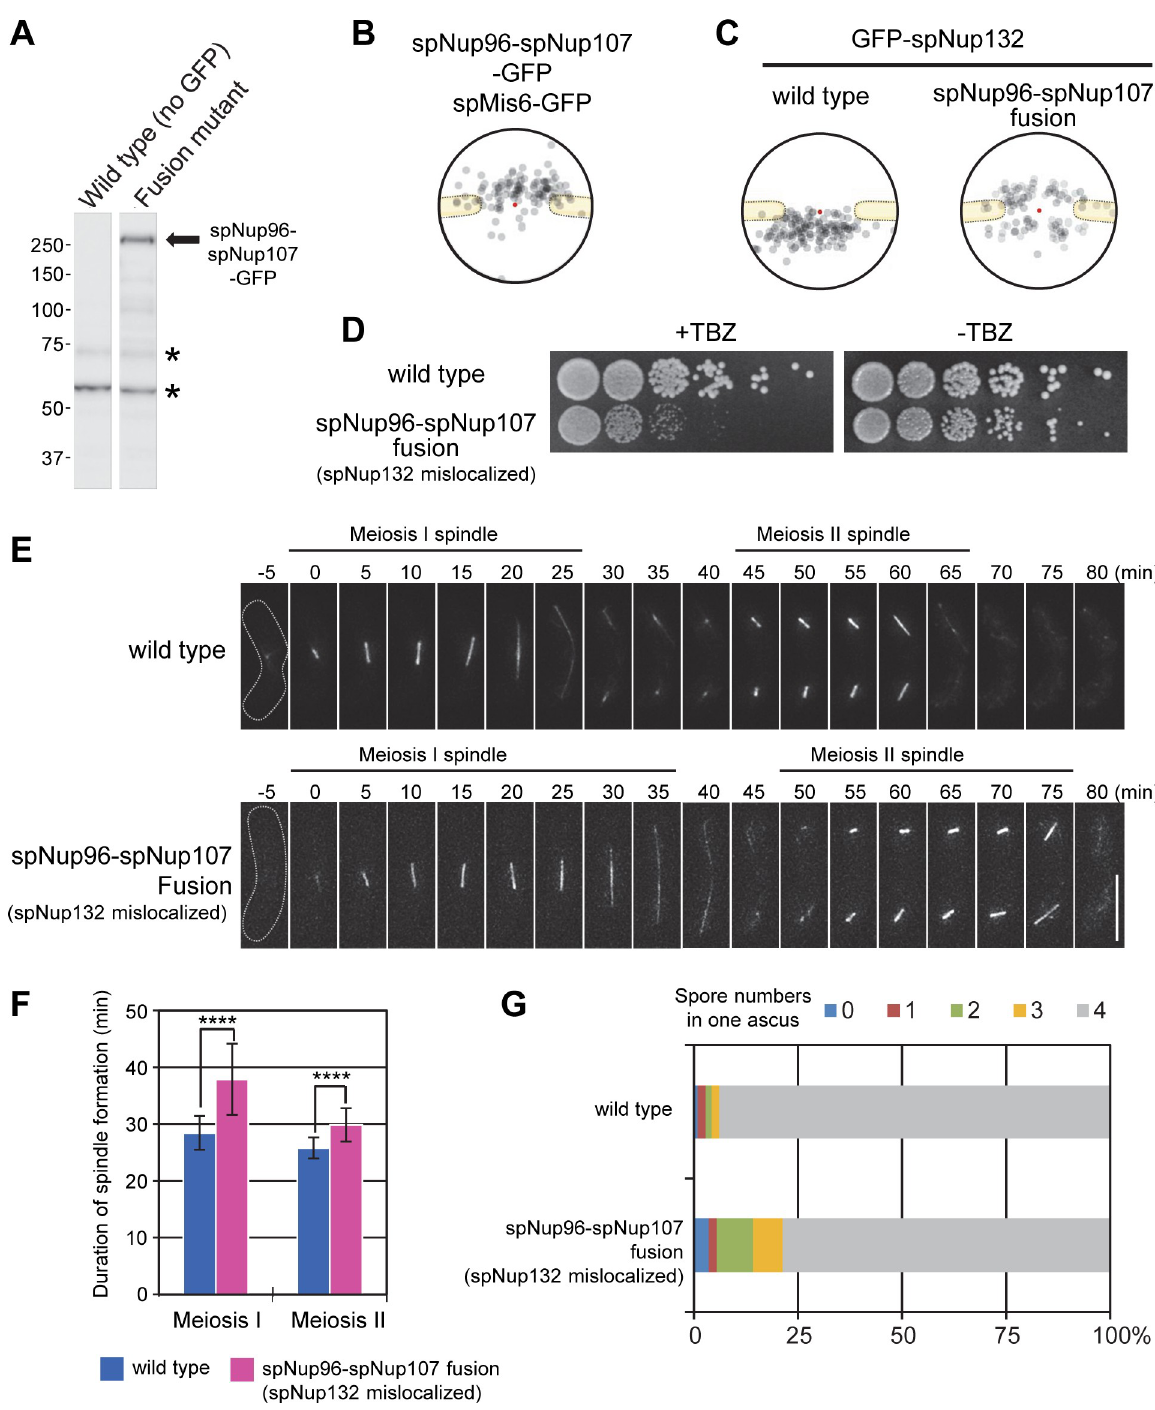
Fig 5. Localization and functional analysis of an spNup96-spNup107 fusion Nup. (A) Western blot analysis of the spNup96-spNup107-GFP fusion protein. Asterisks represent non-specific cross reactions of the anti-GFP antibody. (B) IEM of the spNup96-spNup107 fusion protein. Immunogold distribution of the projected immunoelectron micrographs is shown. Projection of raw IEM images is shown in S5B Fig. Individual IEM micrographs of 20 NPCs are available in S9 Dataset. (C) IEM of GFP-spNup132 in wild type and spNup96-spNup107 fusion backgrounds. Localization of GFP-spNup132 in a wild type background is taken from the data shown in Fig 1B. Projection of raw IEM images is shown in S5B Fig. Individual IEM micrographs of 20 NPCs are available in S9 Dataset. (D) A cell growth assay in the presence (+TBZ) or absence (-TBZ) of 10 μ g/mL TBZ. Five-fold serial dilutions of wild type and spNup96-spNup107 fusion strains were spotted on YES medium containing or